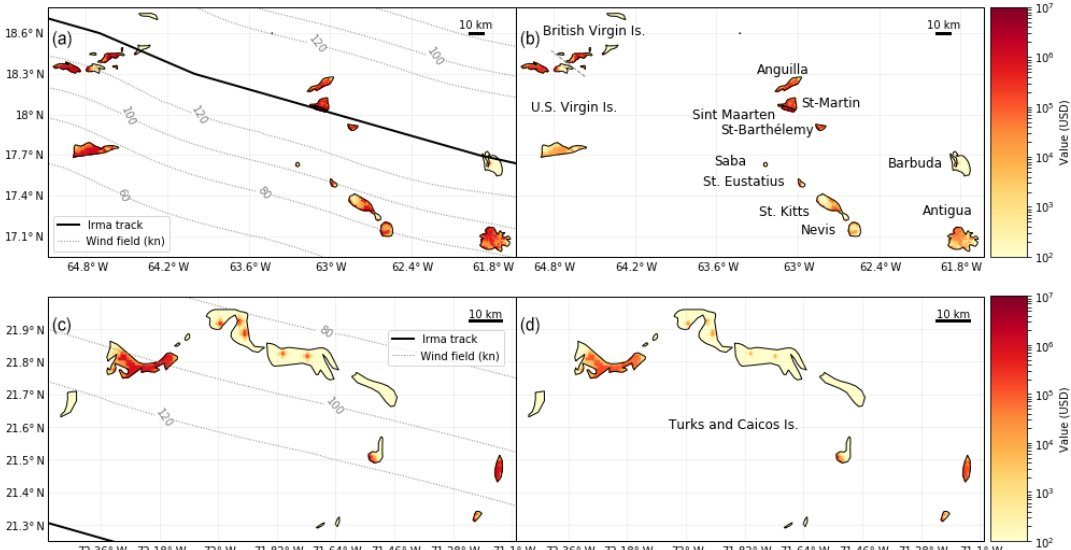
Figure 3. (a, c) Rendered exposed value, contour lines of Irma maximum 1min sustained winds (in knots) and Irma track as modelled by CLIMADA. (b, d) Economic damage generated by Irma computed by CLIMADA.